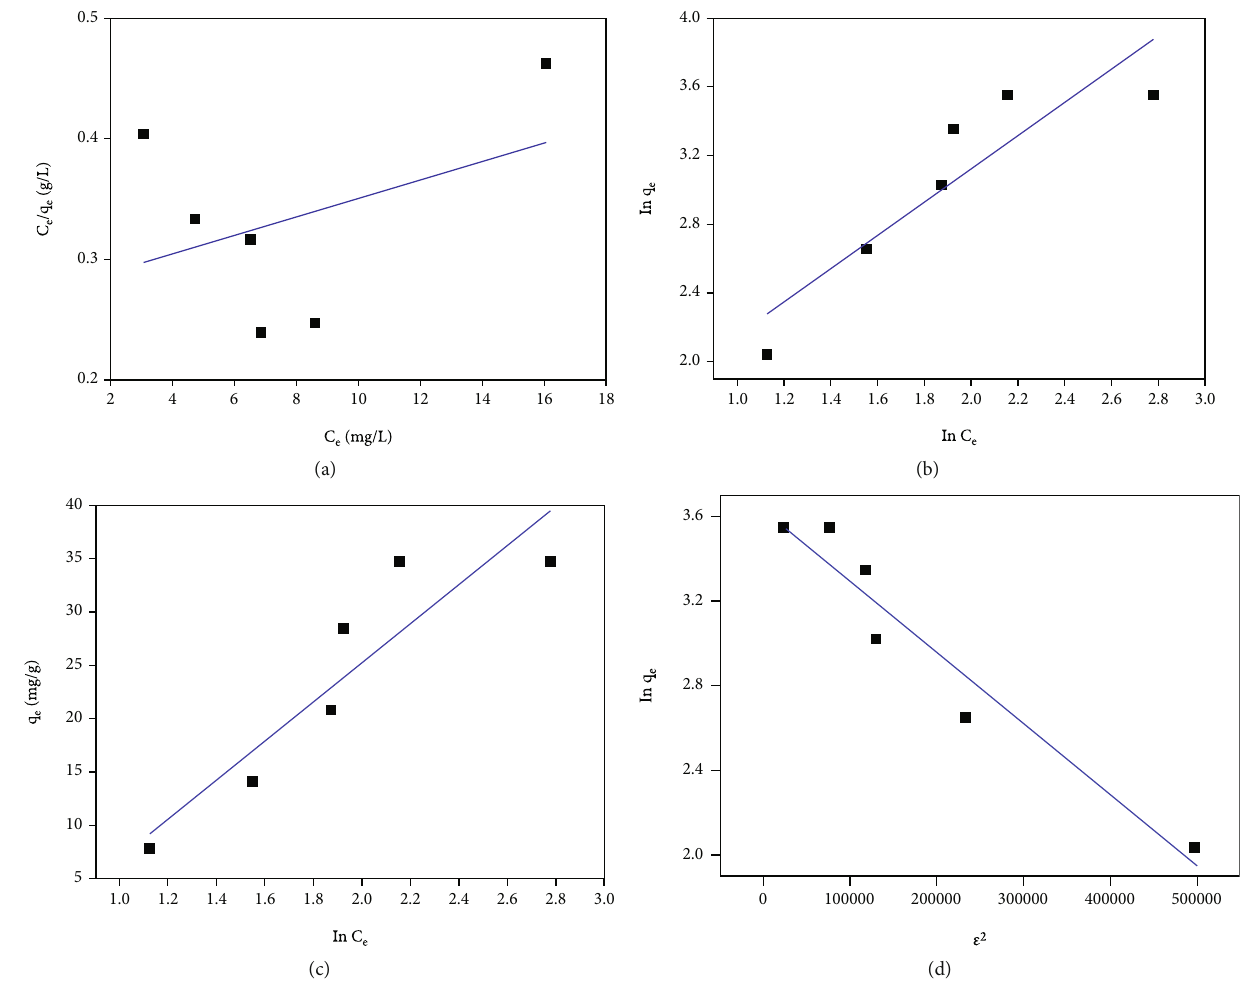
Figure 10: The sorption of MG to CL-KOH using (a) LNR, (b) FRH, (c) TMN, and (d) D-R isotherm models. Table 3: The comparison of sorption capacity of CL-KOH with other described/reported biosorbents on MG.